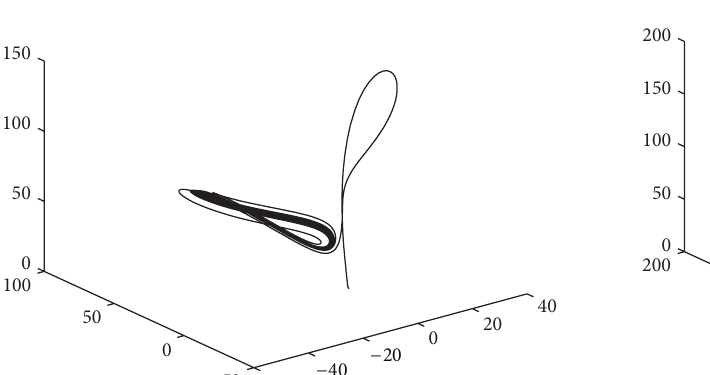
Figure 5: Simulation of system (46).